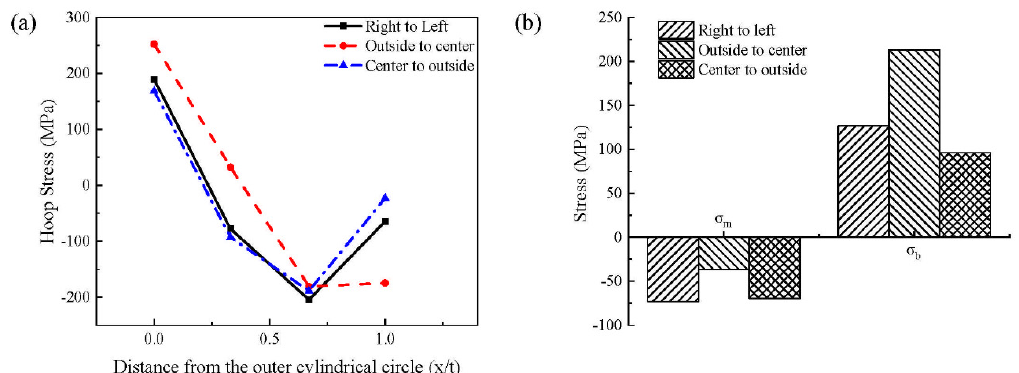
Figure 10. ( a ) Distribution of hoop residual stress in the through-thickness direction after overlaying 1 layer weld, and ( b ) comparison of decomposed components of hoop residual stress with 3 different welding sequence.